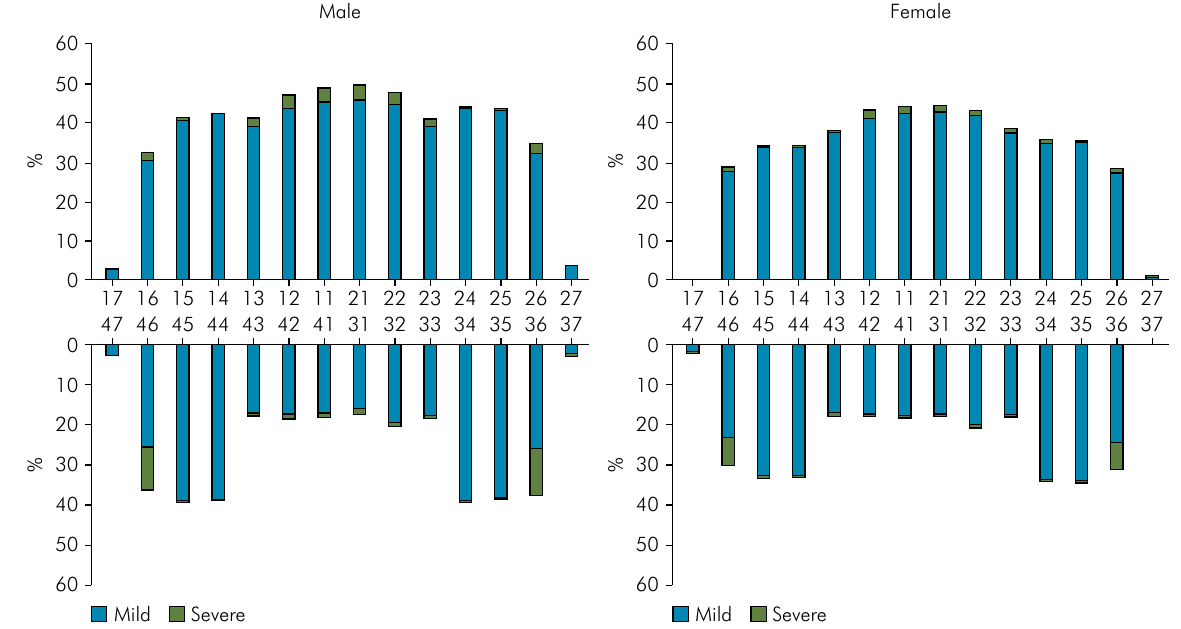
Figure 2. Prevalence of erosive tooth wear according to tooth and